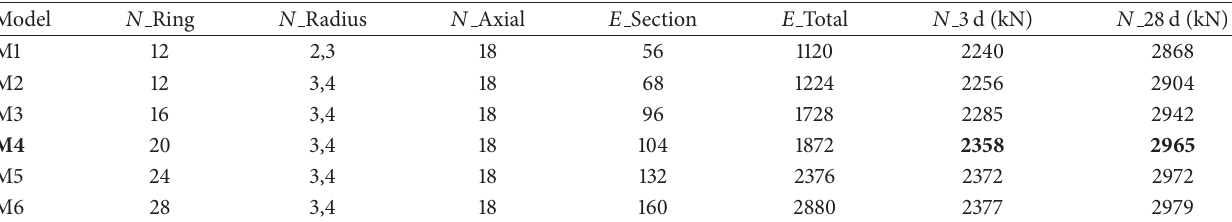
Figure 2: Finite element mesh of (a) concrete and (b) steel tube. Table 2: Meshes parameter and